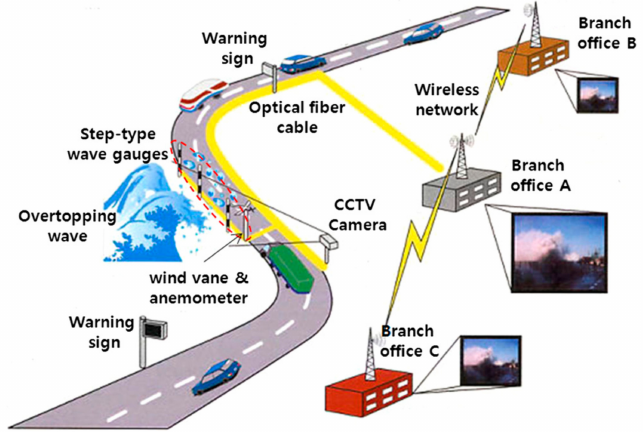
Figure 5. Outline of the overtopping wave monitoring system installed on the National Highway in Japan